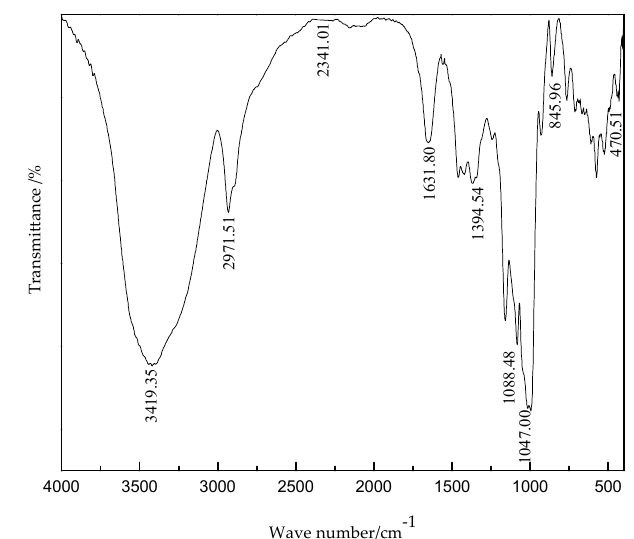
Figure 11. Infrared spectrum of starch.